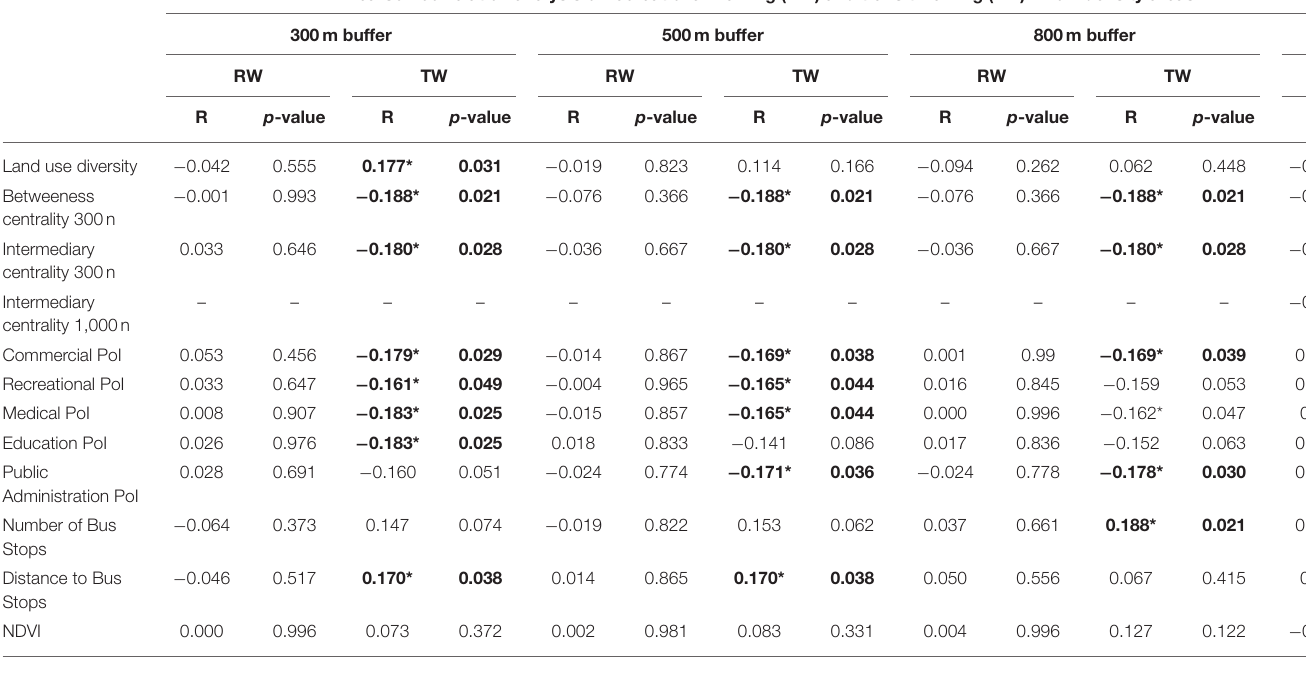
TABLE 4 | Pearson correlation analysis for low, medium, and high-density areas ( n = 597). Pearson correlation analysis of recreational walking (RW) and transit walking (TW) in low density